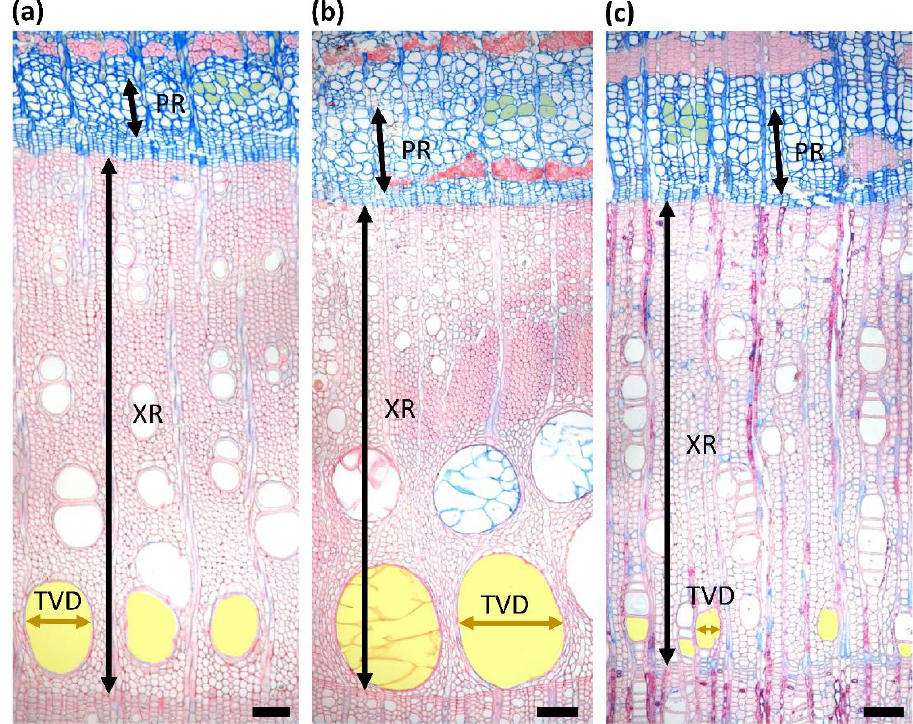
Figure 1. Cross-sections of xylem and phloem increments in 2019 in ( a ) Fraxinus ornus L., ( b ) Quercus pubescens Willd. and ( c ) Ostrya carpinifolia Scop. Area of initial earlywood vessels is marked with yellow; area of early phloem sieve tubes is marked with green color. XR—xylem increment; PR—phloem increment; TVD—tangential diameter of initial earlywood vessels. Scale bars = 100 µm.